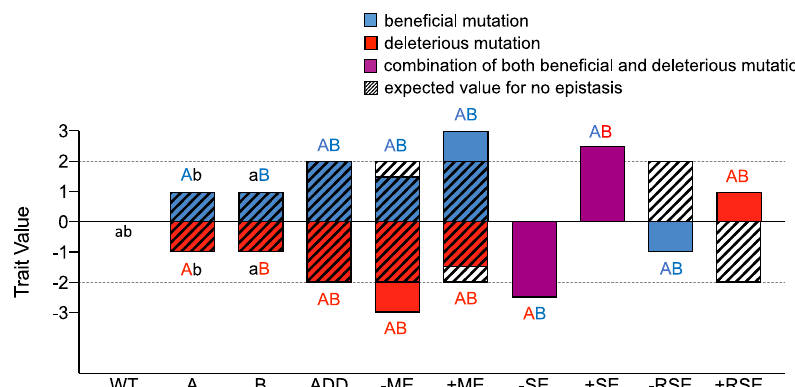
Fig. 5 Explanation of non-additive effects in single mutations A and B. Additivity (ADD) occurs when the sum of the individual effects of mutations A and B is equal to the value in double mutant AB (black diagonal lines). Epistatic effects emerge when the result of combining two individual mutations (or sets of mutations) is non-additive, i.e. the fi tness value after combining mutations A with B to generate a doubly mutated AB variant is not equal to the sum of the individual A and B contributions. Epistatic effects can be positive/synergistic or negative/antagonistic depending upon their result with respect to additivity. They occur in the form of: (i) positive magnitude epistasis ( + ME) if both the single mutations A and B are bene fi cial for a fi tness trait and they produce a greater-than-additive fi tness improvement (or a smaller-than-additive fi tness drop if both are deleterious) when combined together in mutant AB; (ii) negative magnitude epistasis ( − ME) if both the single mutations A and B are bene fi cial for a fi tness trait and they produce a smaller-than-additive fi tness improvement (or a greater-than-additive fi tness drop if both are deleterious) when combined into AB; (iii) positive sign epistasis ( + SE) if one mutation A is deleterious on its own but can enhance the bene fi cial effect of another mutation B when combined into AB; (iv) negative sign epistasis ( − SE) if one mutation A is bene fi cial on its own but can enhance the deleterious effect of another mutation B when combined into AB; (v) positive reciprocal sign epistasis ( + RSE) if both mutations A and B are deleterious alone, but they produce a bene fi cial effect when combined into AB and (vi) negative reciprocal sign epistasis ( − RSE) if both are bene fi cial but they produce a deleterious effect when combined into AB.